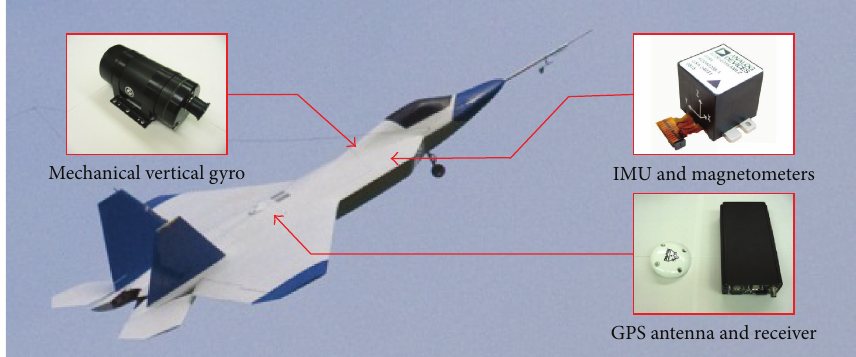
Figure 3: WVU YF-22 research aircraft and relevant